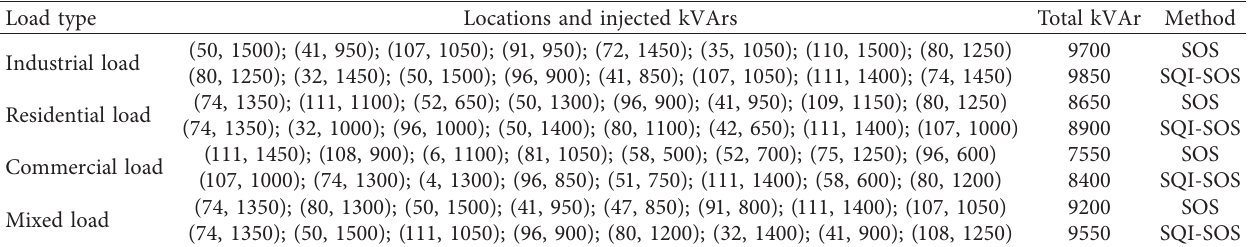
Table 18: Optimal locations and kVArs of capacitors for the 119-bus system with different load models.